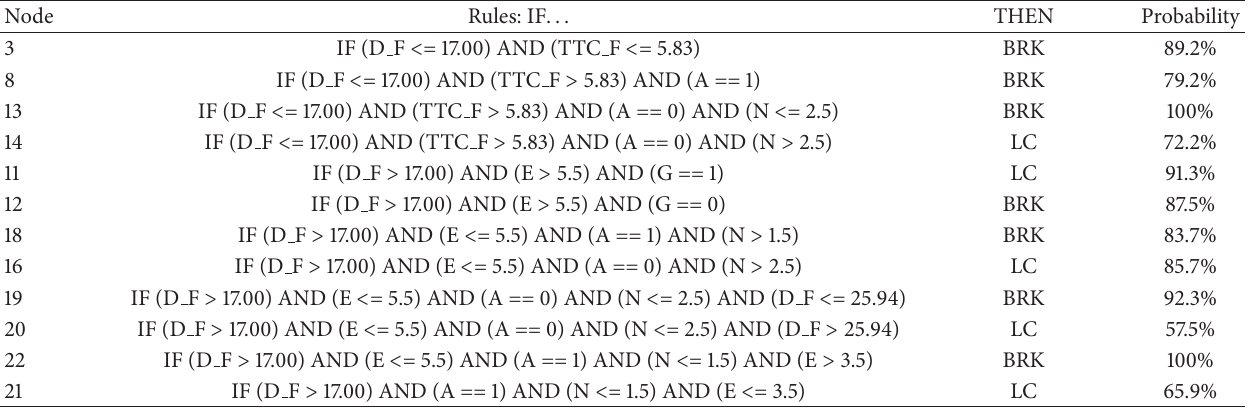
Table 4: DT classification rules.